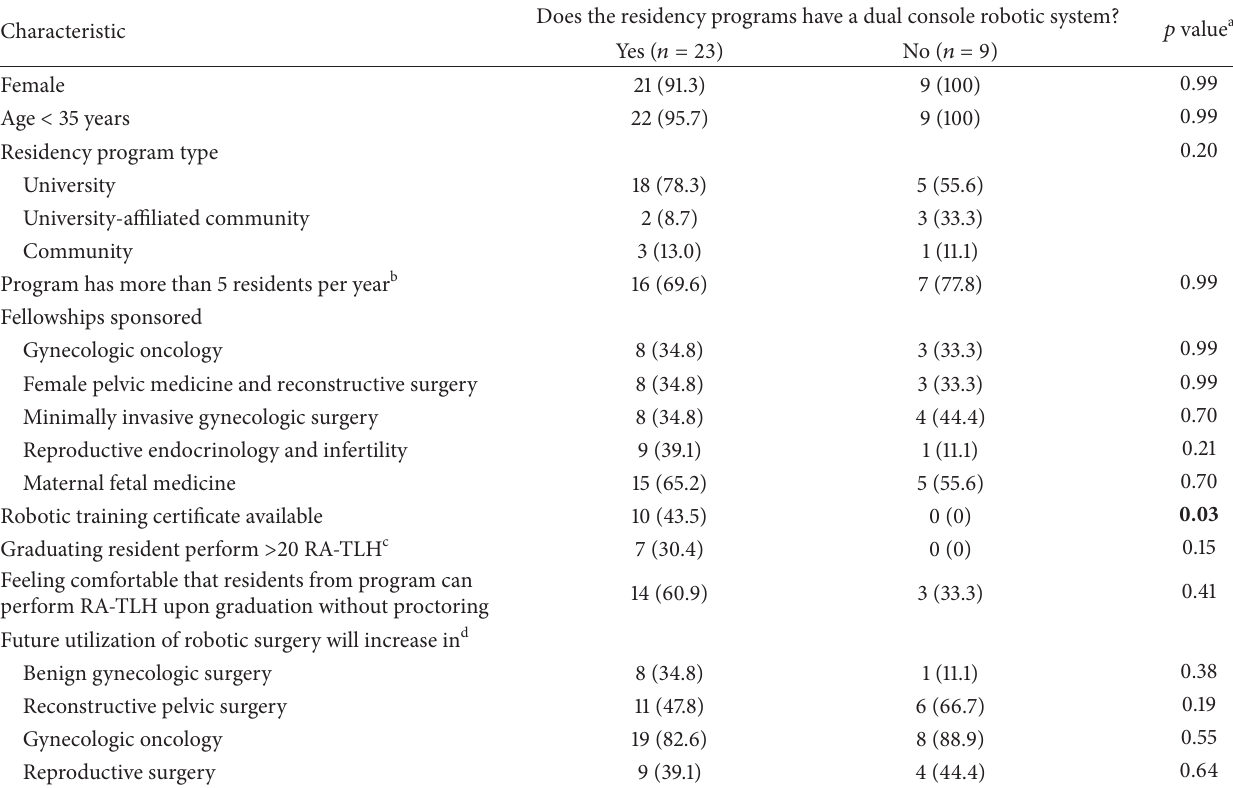
Table 3: Characteristics of residency programs with single versus dual console robotic systems, based on perceptions of graduating obstetrics and gynecology